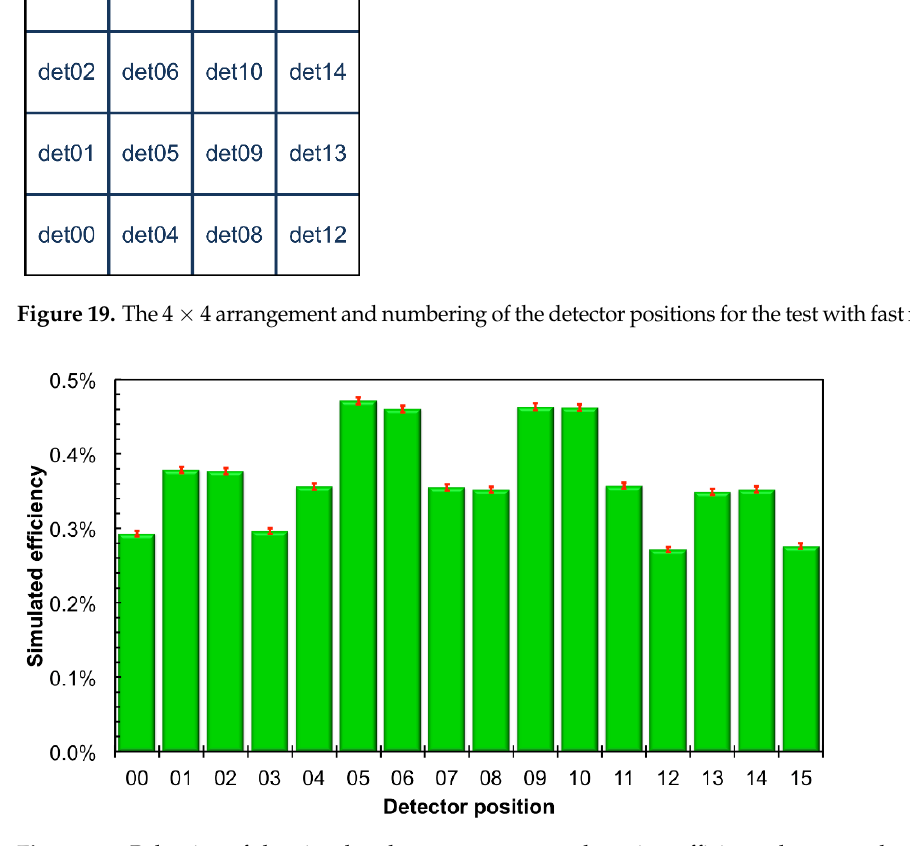
Figure 20. Behavior of the simulated average neutron detection efficiency between thermal and 2.5 MeV in the top position. The efficiency modulation due to geometrical effects is clearly visible. The error bars indicate only the statistical uncertainty.